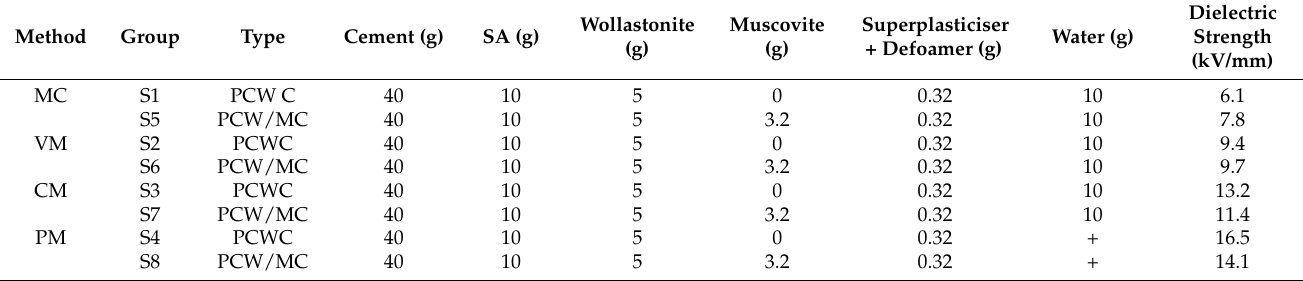
Table 2. Properties of composite samples from different manufacturing methods.